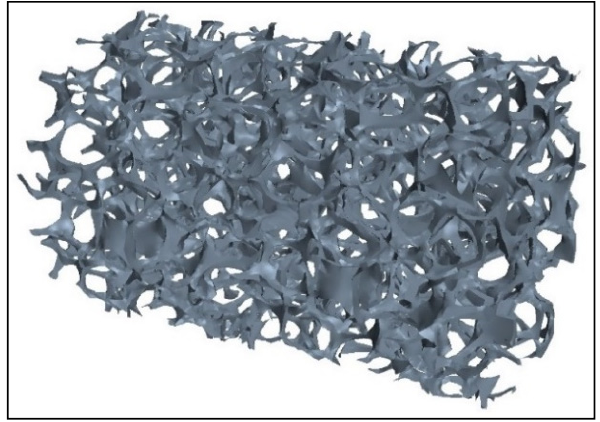
Figure 2. 3D image of metal foam packing applied in the experiments.